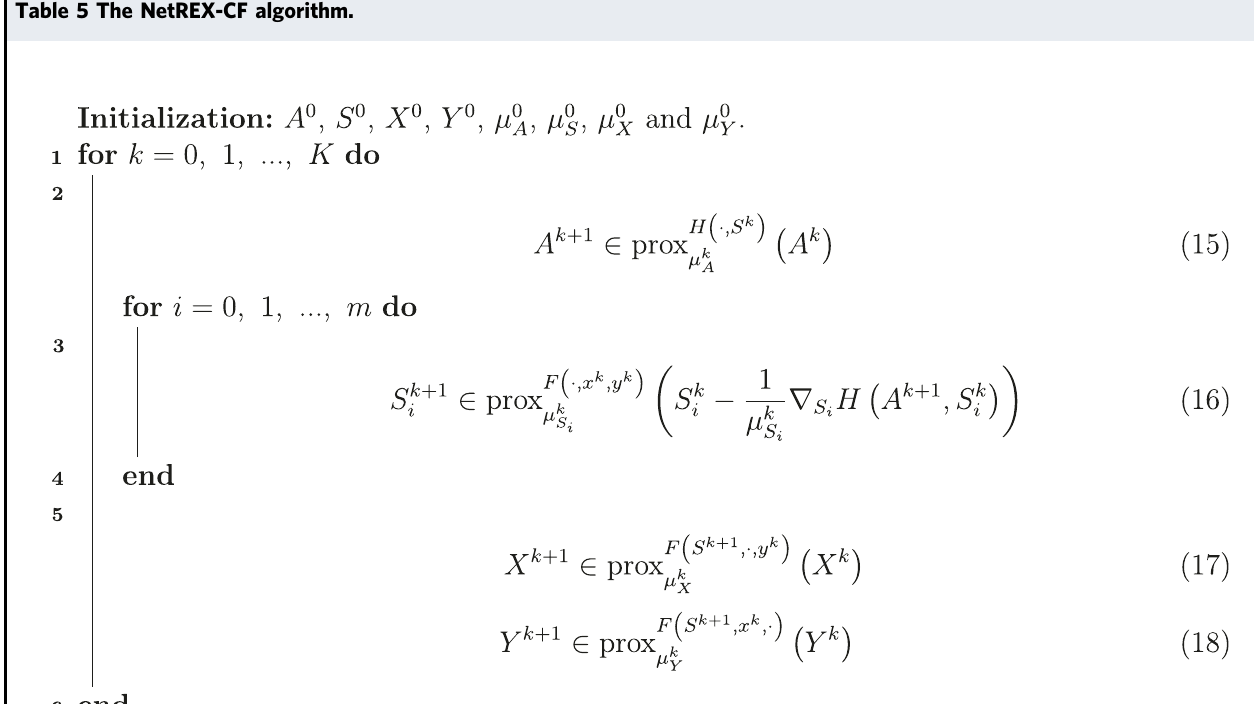
Table 5 The NetREX-CF